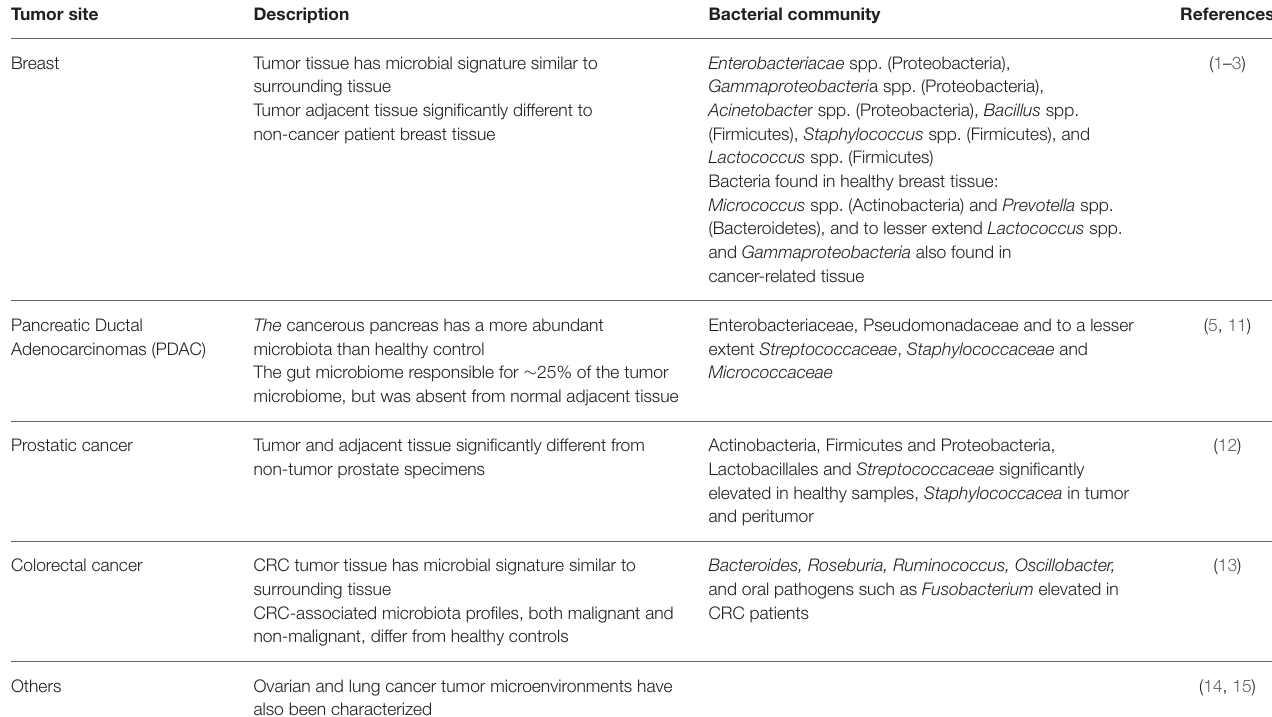
TABLE 1 | Tumor sites with suspected bacterial